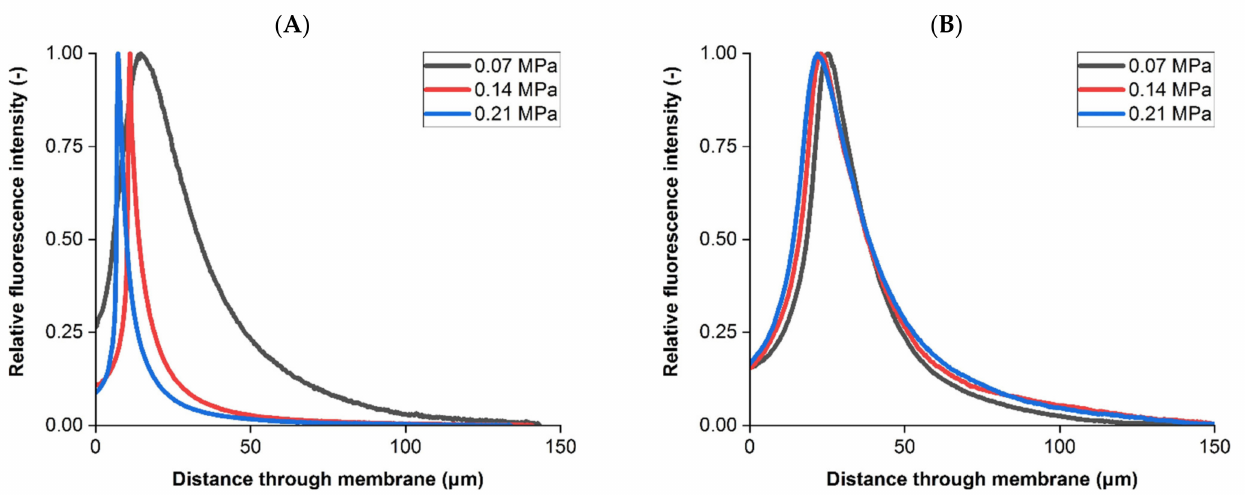
Figure 6. Intensity profiles of fluorescent liposome retention. ( A ) Upstream membrane profiles at three differential pressures. ( B ) Downstream membrane profiles at three differential pressures. Intensity profiles presented are based on measurements from all 2D slices from a single sample imaged using CLSM, with intensity relative to each respective peak value displayed and further compared in the text. Following dual-layer filtration each individual membrane was removed from the filter housing and imaged using confocal microscopy